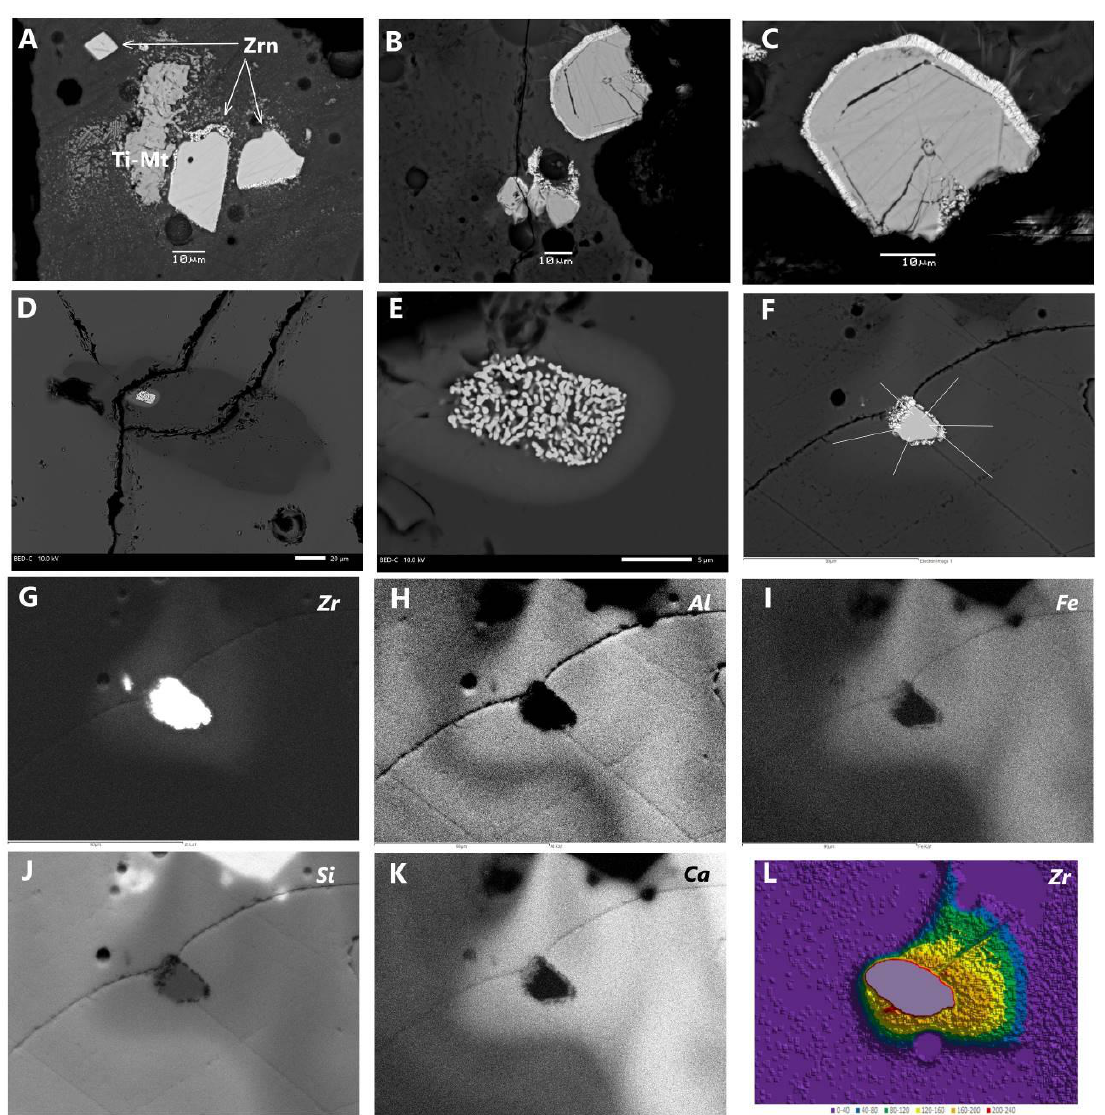
Figure 11. Zircon grains with different degree of decomposition into constituent oxides. ( A , B ) Adjacent grains ranging from perfectly facetted (upper left in ( A )) to those with partial decomposition on the rim. ( C ) Zoomed grain from ( B ) showing decomposition of the cracked region (bottom right). ( D , E ) Fully decomposed grain residing inside a relic quartz grain (dark grey in ( D )). ( F – L ) A partially decomposed grain. Direction of its motion in melt (see text for detail) — towards the bottom left corner of the image. Fine lines show directions of chemical profiles. ( G – K ) elemental maps (( G ) — Zr, ( H ) — Al, ( I ) — Fe, ( J ) — Si, ( K ) — Ca). ( L ) 3D visualization of Zr distribution for the same grain after repolishing.